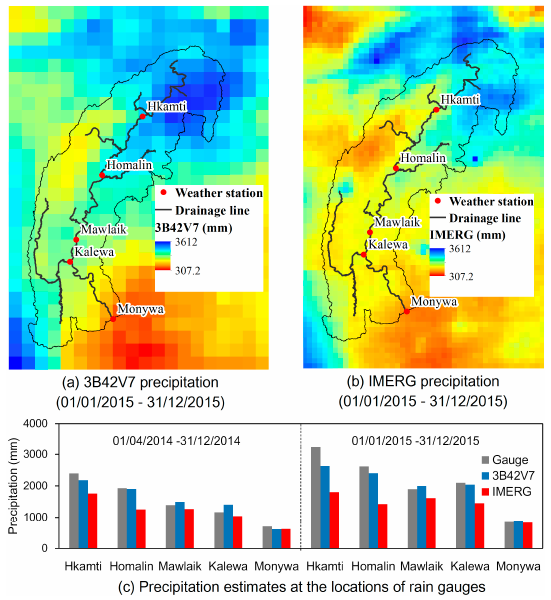
Figure 3. Spatial distribution of precipitation estimates from: ( a ) 3B42V7; and ( b ) IMERG satellite precipitation products from 1 January to 31 December 2015; and ( c ) 3B42V7 and IMERG precipitation estimates at the locations of main weather stations in comparison with gauge-based daily precipitation data during the periods of 1 April–31 December 2014 and 1 January–31 December 2015.